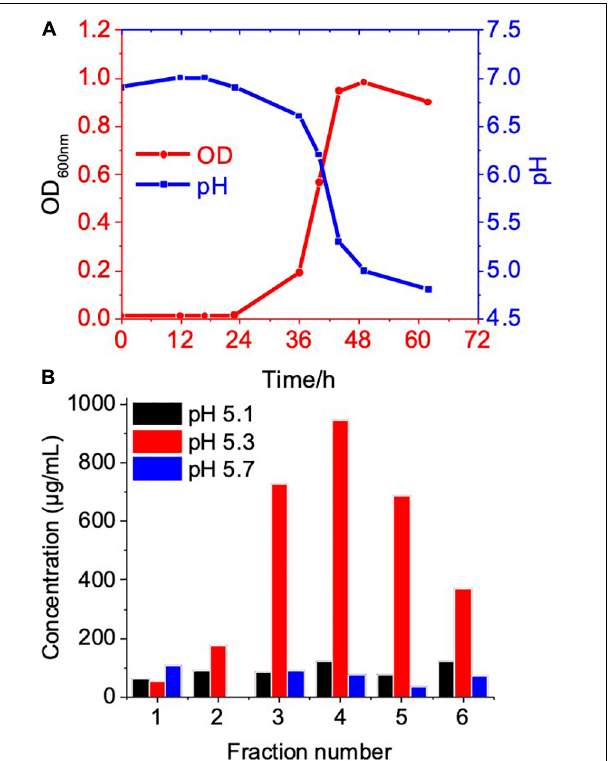
FIGURE 3 | Growth phase related OMV production in C. ochracea. (A) Time vs Growth curve of C. ochracea and pH profile of the nutrient medium measured during the growth. (B) Total protein concentration of OMV from gradient purified fractions of stationary phase (pH: 5.1), late exponential phase (pH: 5.3), and mid-exponential phase (pH: